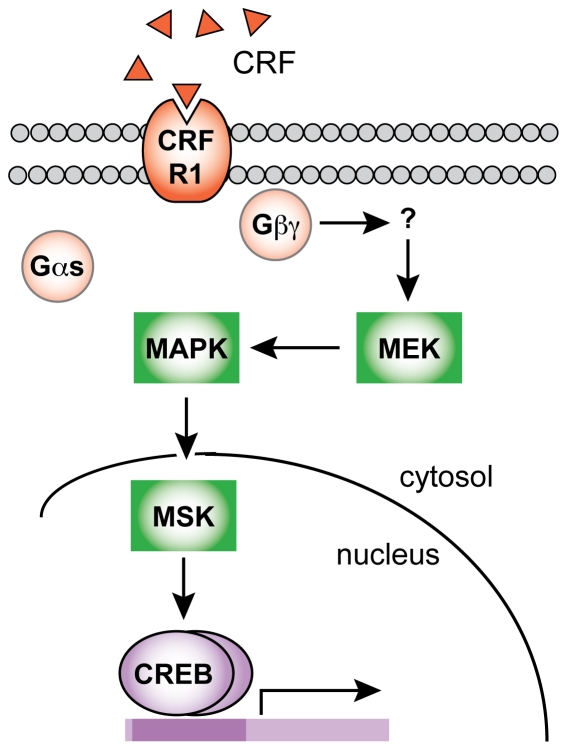
Proposed mechanism of CRF-induced CREB phosphorylation in striatal neurons.CRF binds to Gαs-coupled CRFR1, leading to a Gβγ-dependent activation of MEK and MAPK, resulting in downstream CREB phosphorylation.